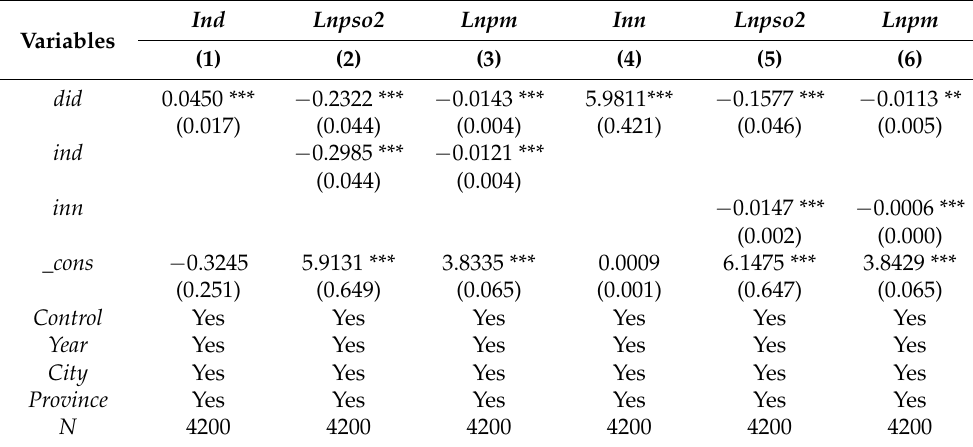
Table 10. Intermediary effects